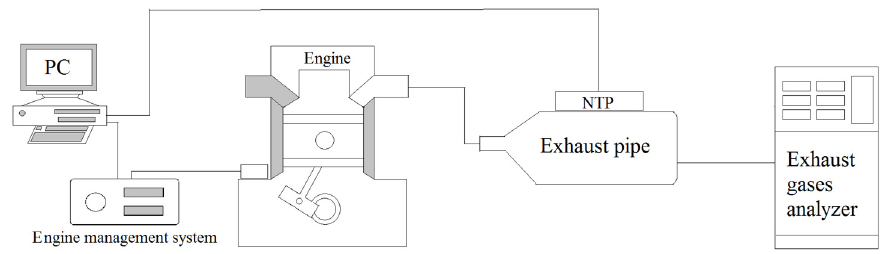
Table 5. The range of each exhaust gas.